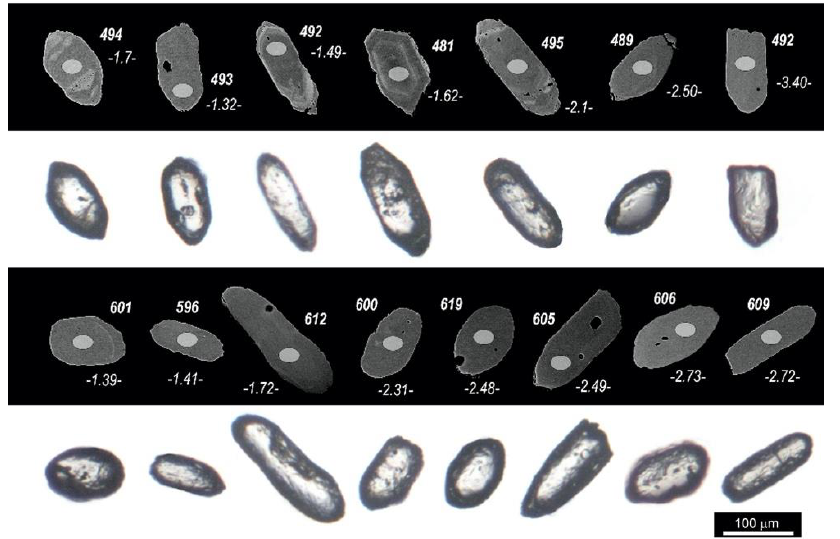
Figure 4. Backscattered electron images and optical photomicrographs of analysed zircons from tb-2009-7 sample (schist). Ellipses mark analytical spot locations and the text shows spot names (italics) and 208 Pb/ 236 U age in Ma (bold).